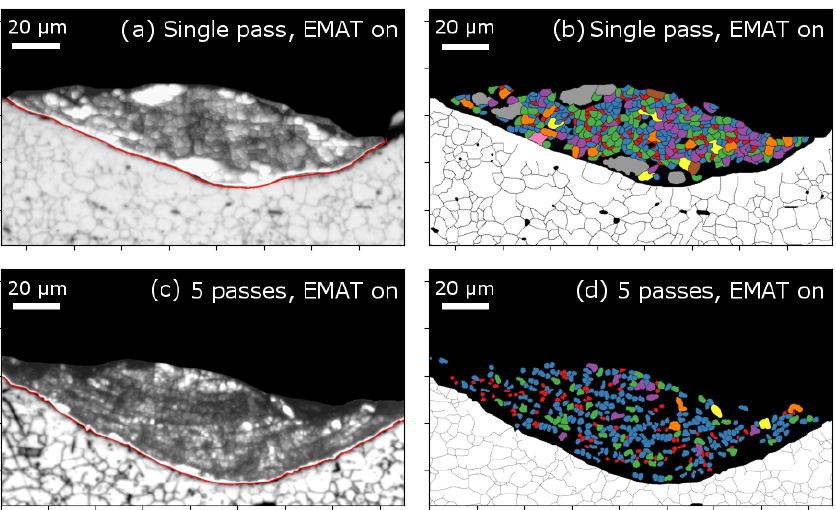
Figure 4. Metallographic images of microstructure of the AISI 321H stainless steel plate after pulsed laser exposure with EMAT turned on: ( a ) single laser pass and ( c ) five laser remelting passes. For the purpose of statistical analysis, the micrographs are computationally segmented and the grains are colored according to their size in ( b , d ) correspondingly. The same colors are used in Figure 5 (at the top of each histogram) in order to quantify the grain size intervals.